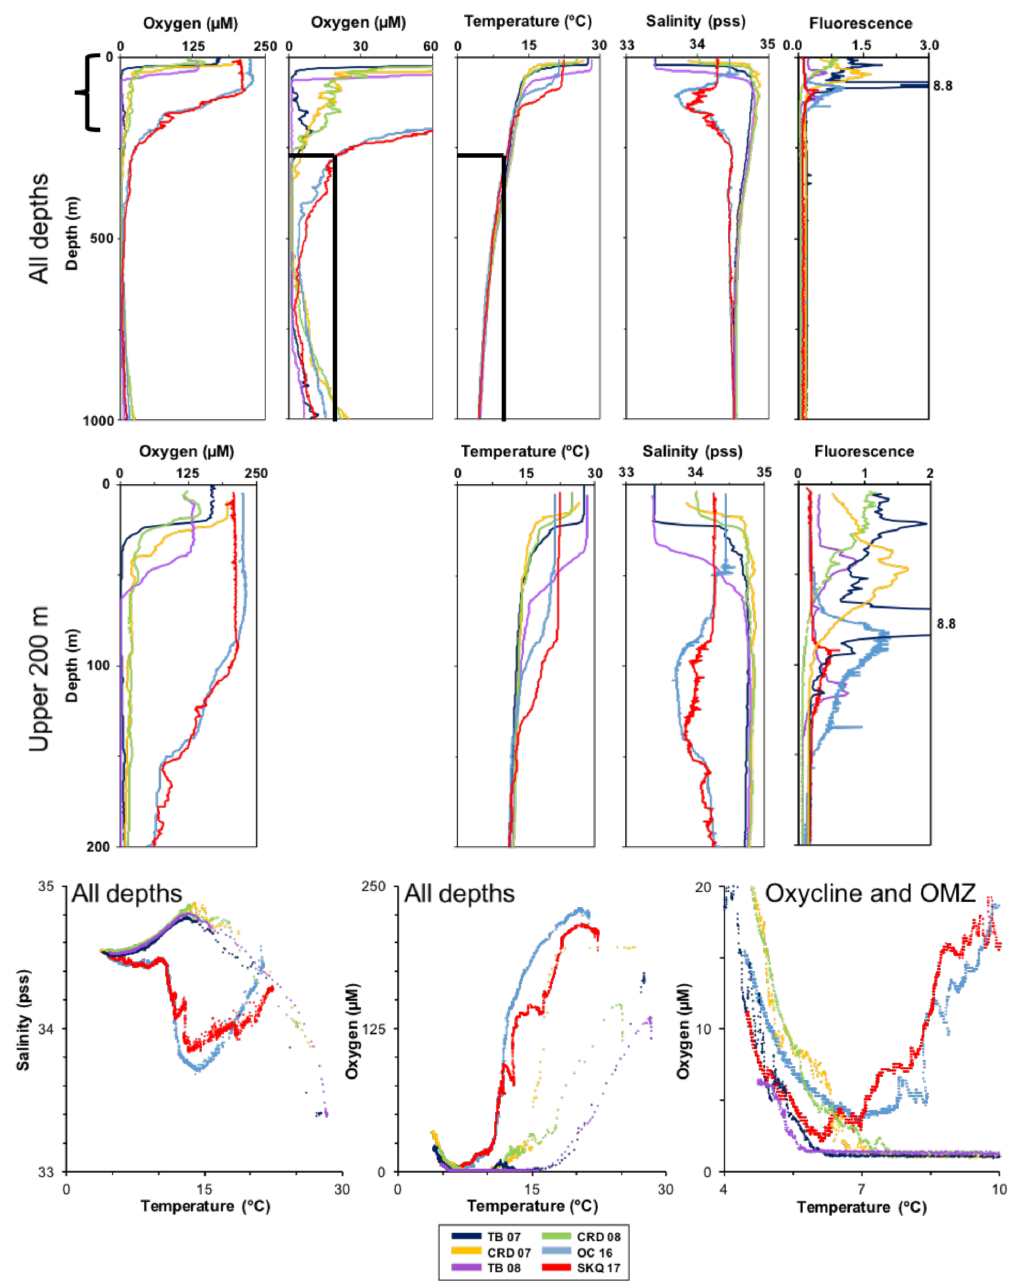
Figure 2. Hydrographic data. Top row: hydrographic profiles for 0–1000m (noted as “All depths”). Each station (colors) is represented by one profile for each variable; all stations are included for that variable in one graph. Stations are noted by abbreviation and year. Two versions of the oxygen profiles are shown: a full range version (0–250µM) to encompass oxygen from the surface to depth (top left) and a higher-resolution version with a smaller oxygen range (0–60µM) to highlight the OMZ core and oxycline variability between stations (top row, second from left). Second row: similar profiles for the upper water column (noted as “Upper 200m” and with its depth range indicated by the bracket on the “All depths” plot). Only a single oxygen range is used for this well-oxygenated part of the water column. Bottom row: Temperature–salinity diagram (bottom left) and two temperature–oxygen diagrams, with the first (bottom middle) encompassing the full range of these variables and the second (bottom right) highlighting the smaller temperature and oxygen ranges and variability associated with the OMZ core and oxyclines at the different stations (data range shown by the outlined box in the “All depths” oxygen and temperature